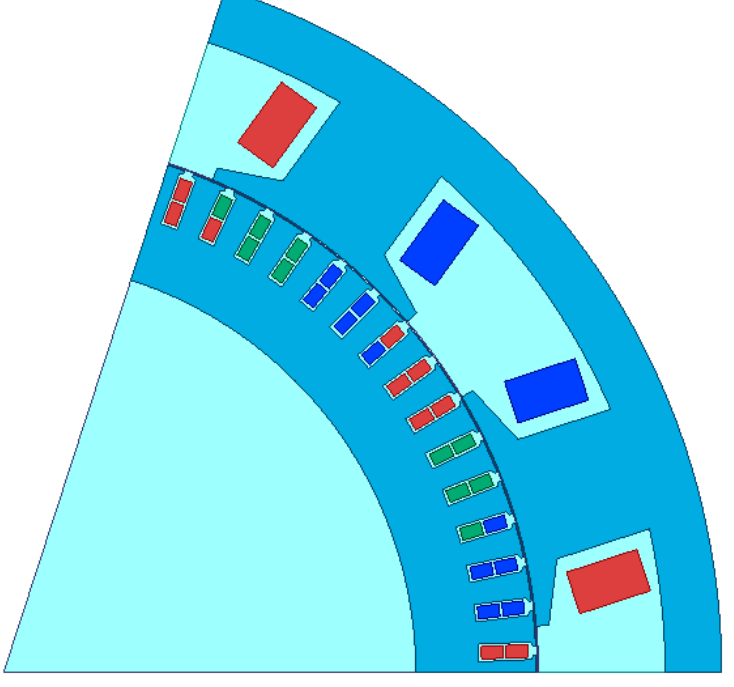
Figure 6. The 1/5 model of the exciter.